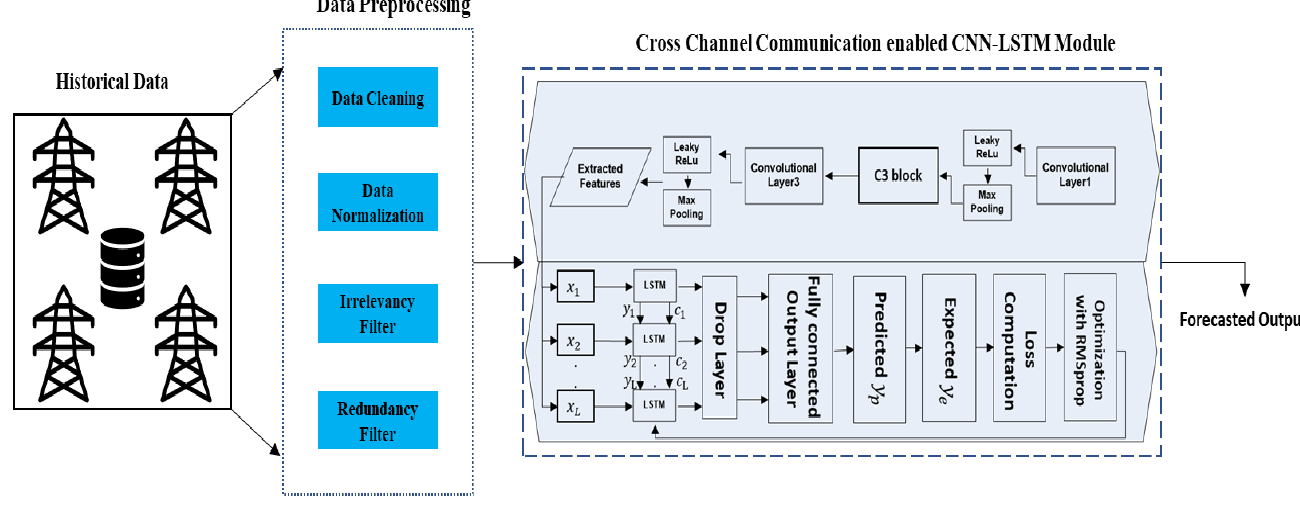
Figure 1. Pictorial view of the proposed C3-enabled CNN-LSTM Model.